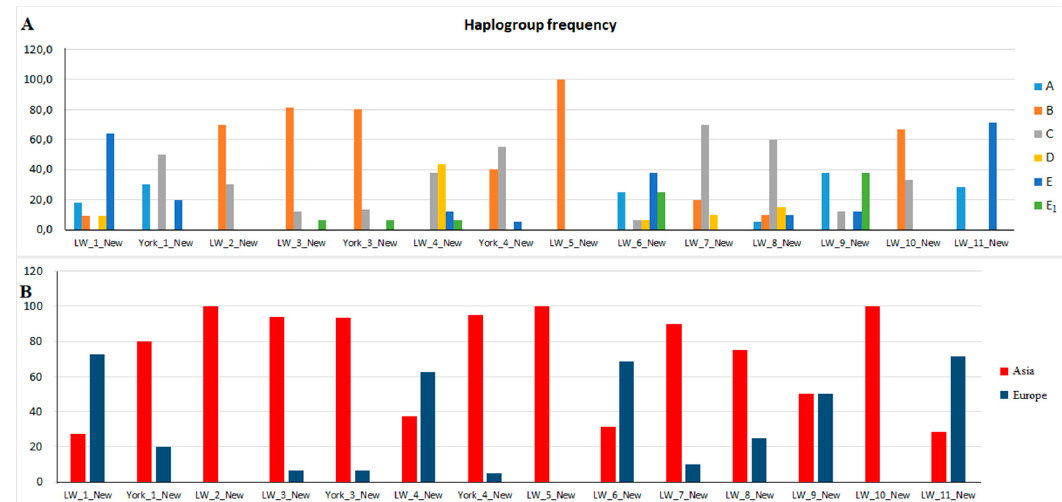
Figure 4. Frequencies of mtDNA haplogroups in New pigs ( A —frequency distribution of haplogroups A, B, C, D, E and E1 in the pigs of the group New from different farms; B —frequency distribution of haplogroups Asia (A, B, C) and Europe (D, E, E1) in the pigs of the group New from different farms).